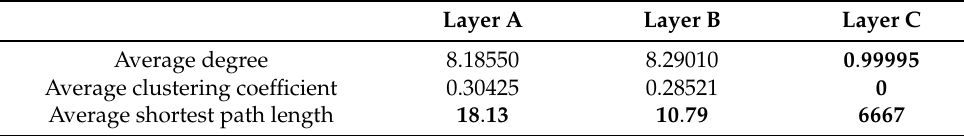
Table 1. The statistical indicators of multi-layer network